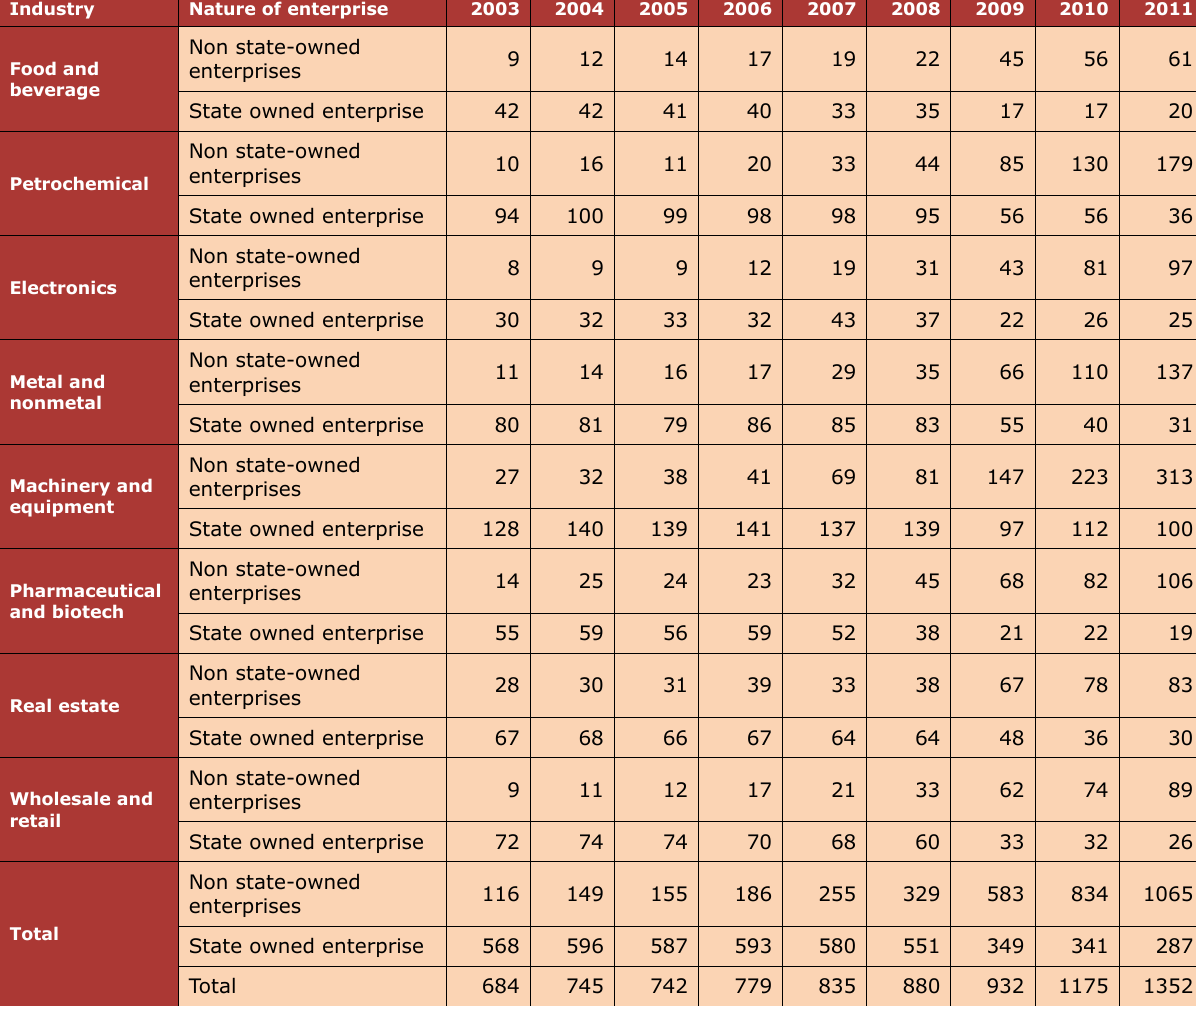
Table 1. Distribution table of companies in different industries over the period